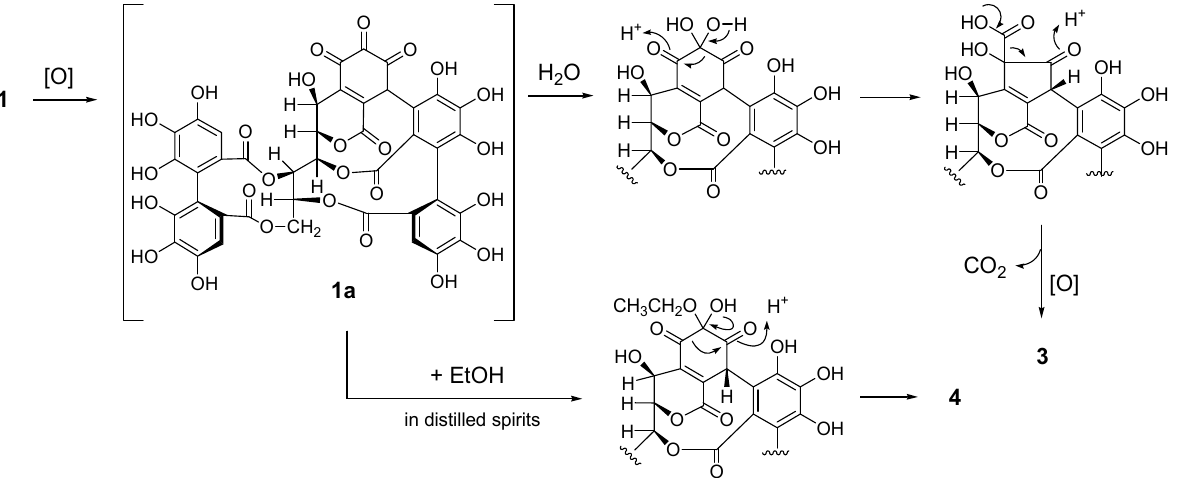
Scheme 1. Proposed chemical mechanism of the oxidative degradation of 1 .